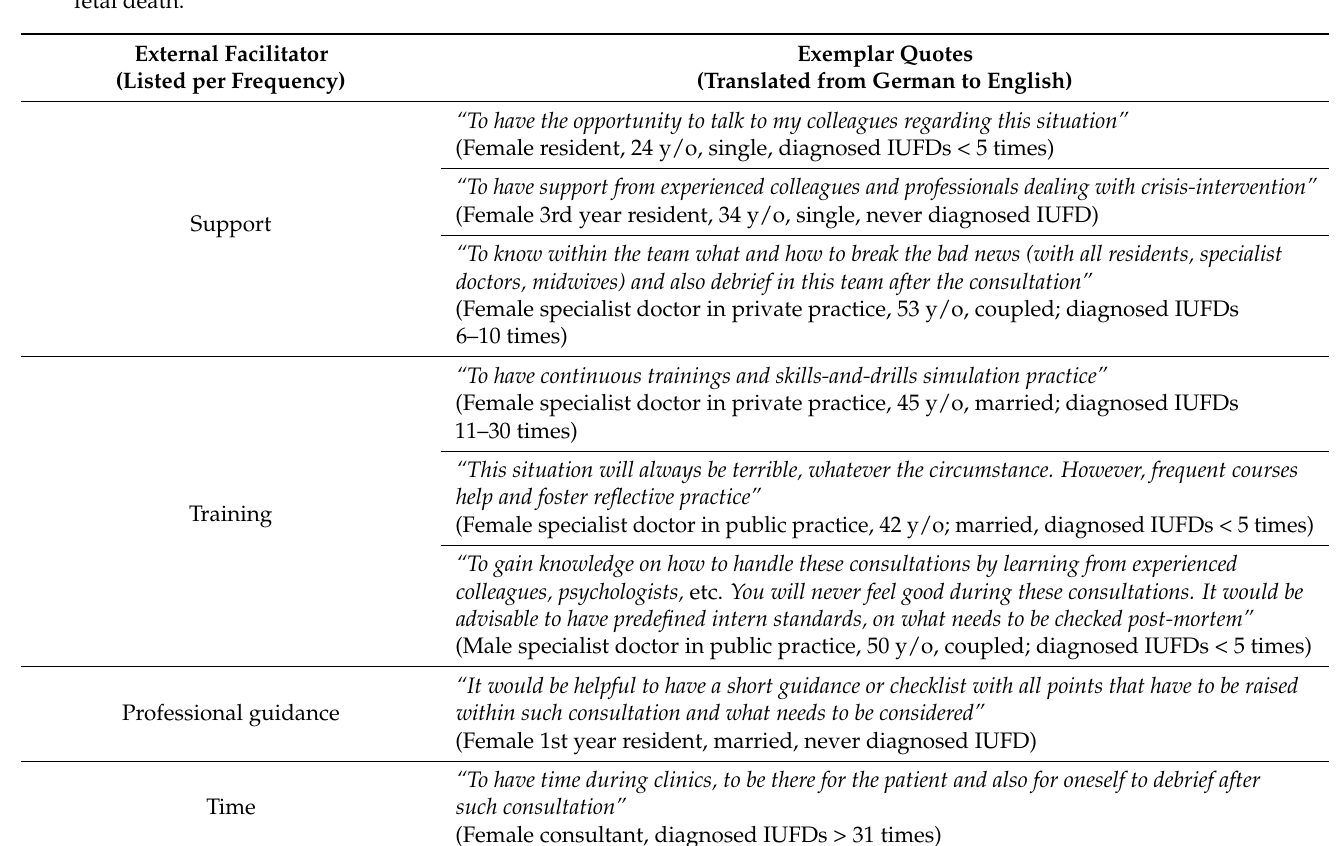
Table 2. Sample narratives by obstetricians expressing their spectrum of external facilitators when delivering news of fetal death.